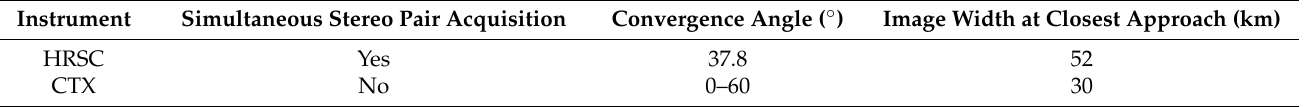
Table 2. Summary of the photogrammetric configurations for the instrument used for DTM generation in this